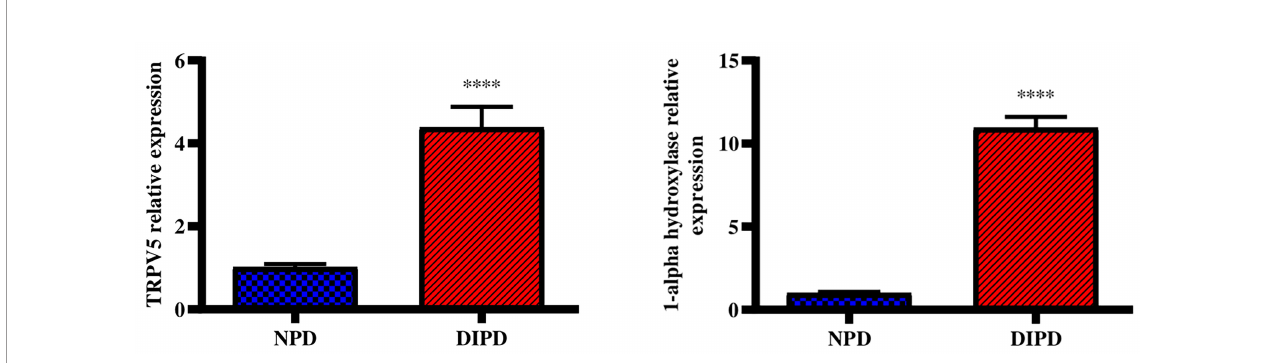
FIGURE 4 | Evaluation of renal calcium transport through renal TRPV5 and 1-alpha hydroxylase gene expression in the non-pre-diabetic (NPD) group and diet-induced pre-diabetic (DIPD) group (n=6, per group).Values are presented as mean ± SEM. ****= p < 0.0001 by comparison to NPD.